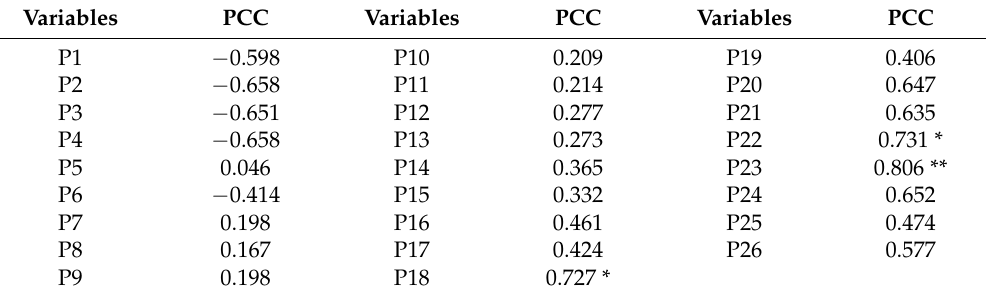
Table 4. PCCs between 26 components and ET-1.